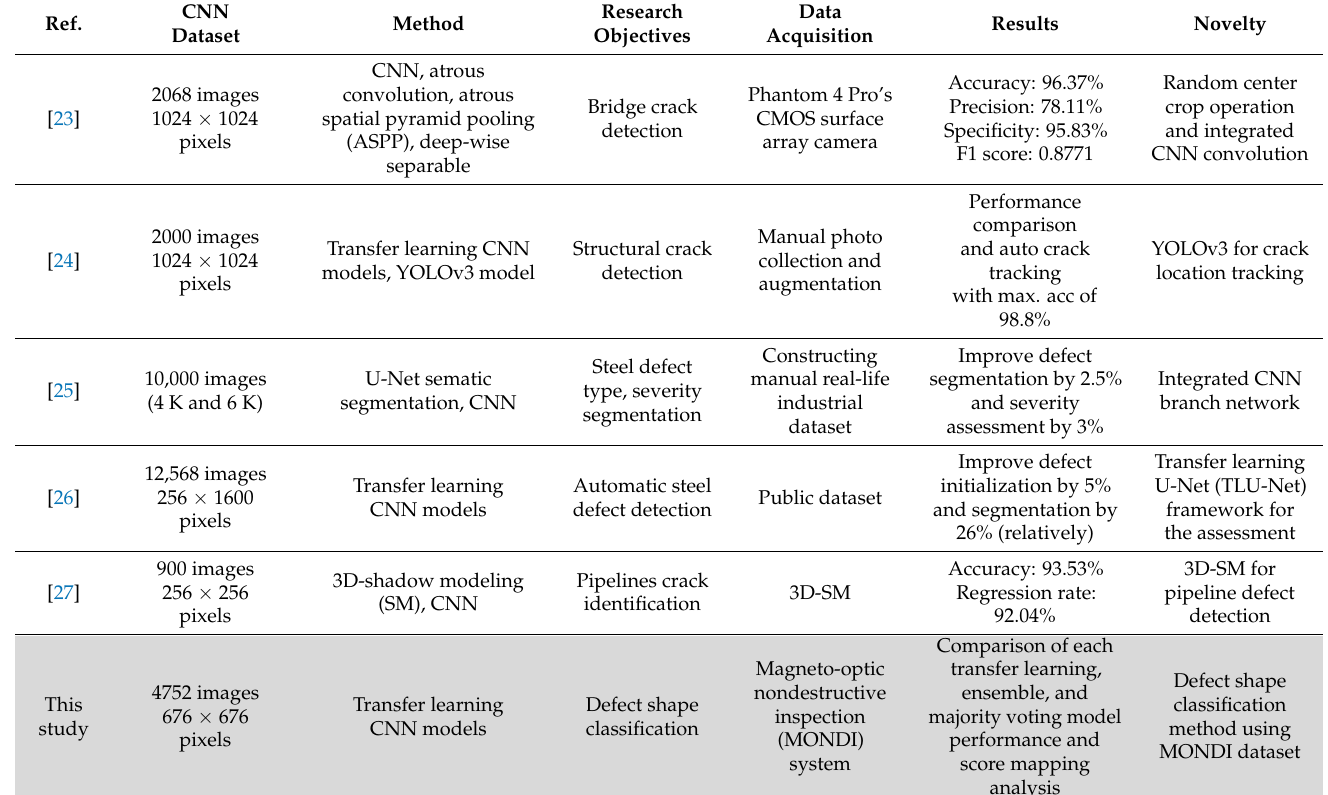
Table 1. Surface defect evaluation based on a deep convolutional neural network (CNN) model.